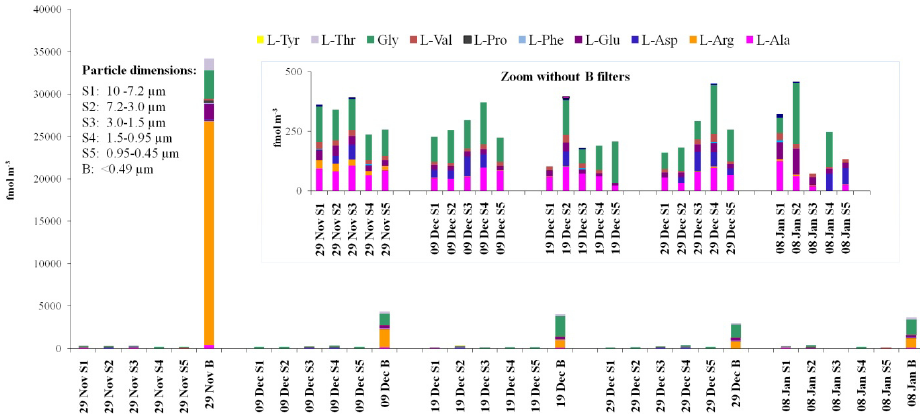
Figure 2. Amino acid size distribution in the samples collected during the summer of 2010–2011 at Mario Zucchelli Station (Antarctica).